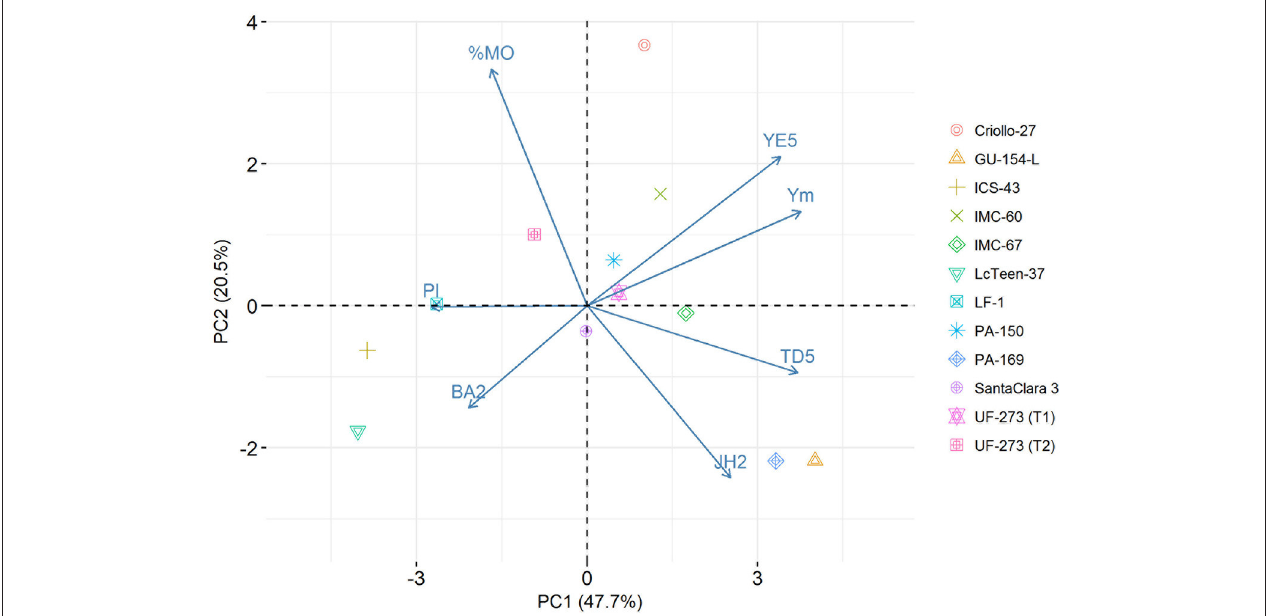
FIGURE 3 | Biplot of selected traits: proportion of Monilia infected pods (%MO), branch angle (BA2), Jorquette height (JH2), pod index (PI), trunk diameter at year five (TD5), yield efficiency at year five (YE5), mean yield ages 2–7 (Ym). The first two PCs of the predicted values for the L7 population account for 68.2% of the total variation. The scores of the parents are overlayed in the plot.